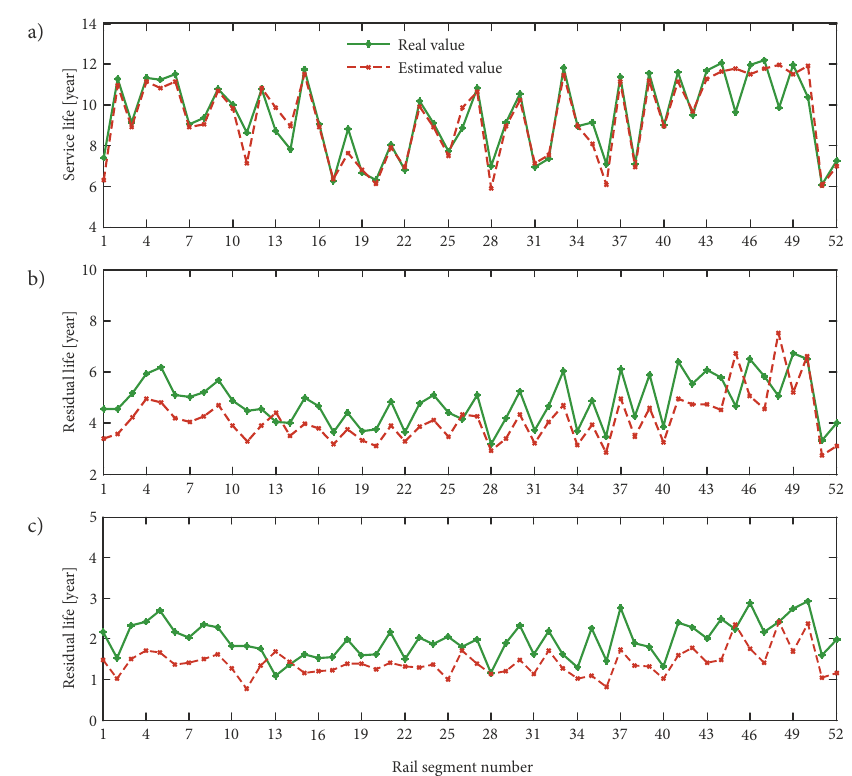
Figure 5. Comparison of estimated and true values of the service and residual lifetimes of the 52 selected rail segments: a – service life; b – residual life when one severe or broken rail defect occurred; c – residual life when two severe or broken rail defects